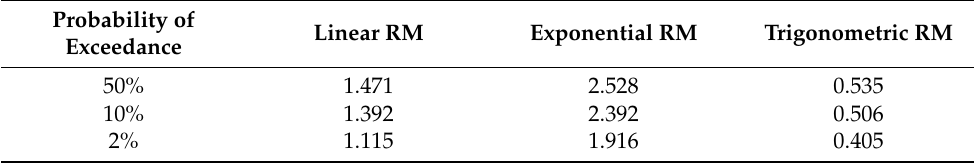
Table 4. Resilience linear LM (for the selected probability of exceedance).